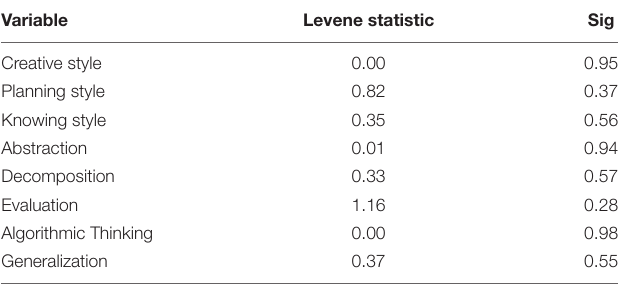
TABLE 2 | Verification of homogeneity test of variance*.